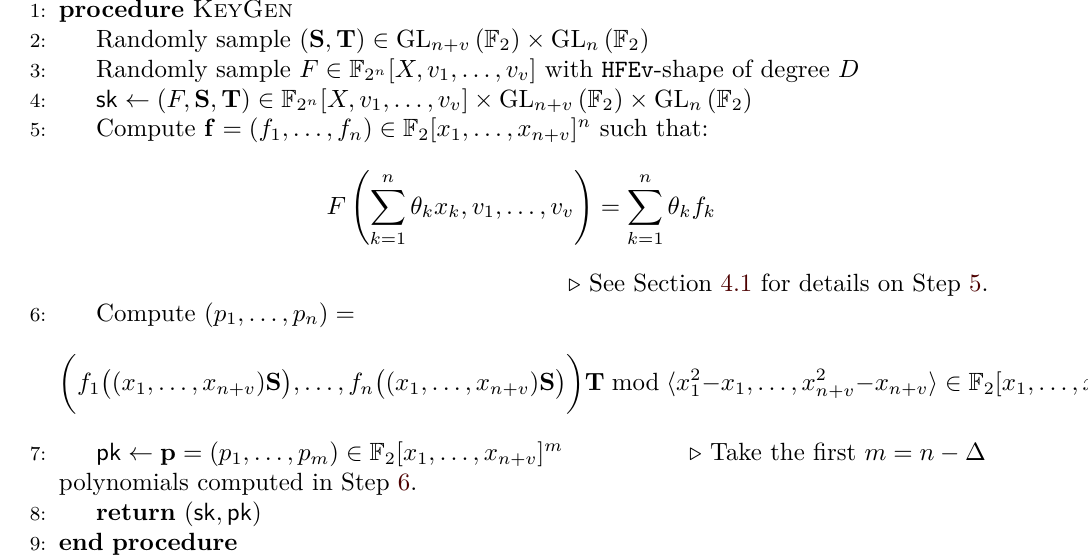
Algorithm 1 PK/SK generation in HFEv-